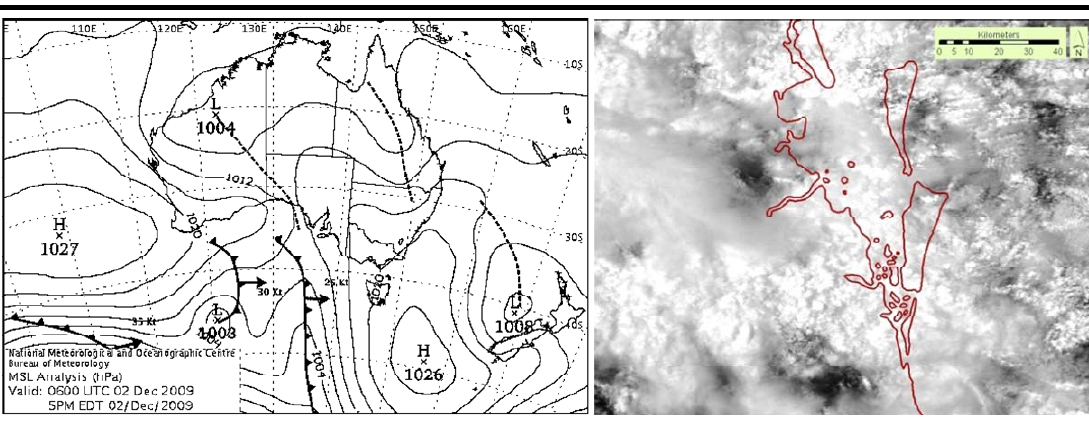
Figure 2. Mean sea level pressure (MSLP) chart for 06:00 UTC and MODIS band 1 image